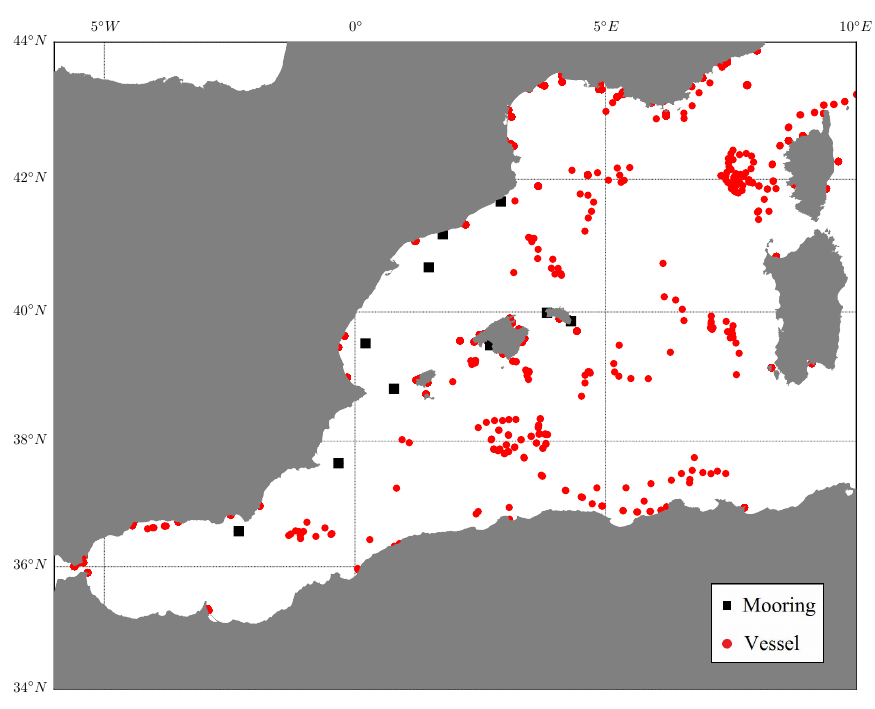
Figure 2. Map of the Western Mediterranean Sea showing an example subset with location of observations from moorings (black squares), and vessels (red